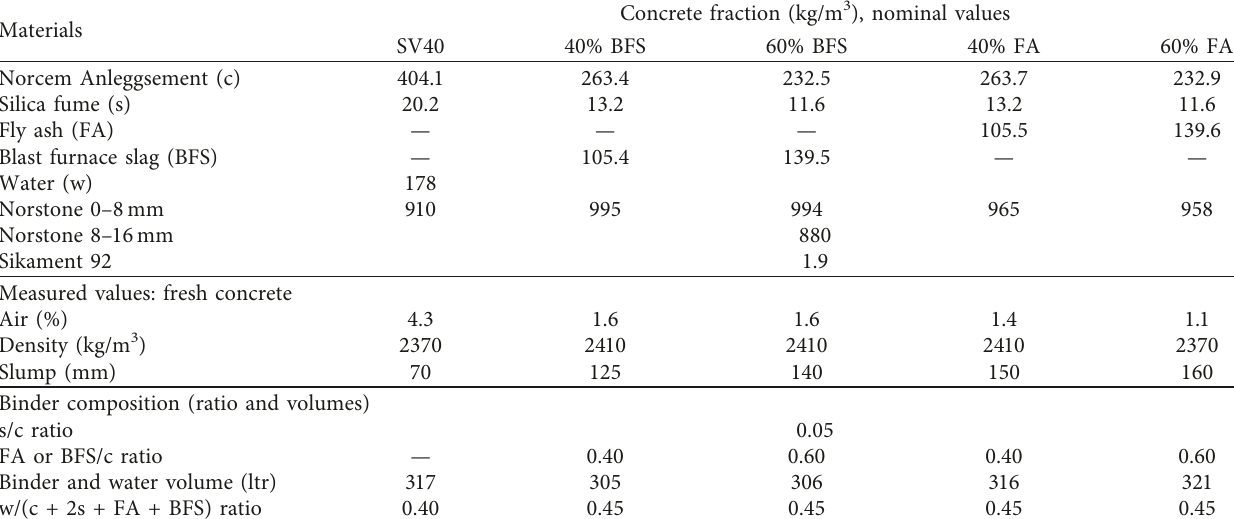
Figure 1: Bjørvika submerged Table 1: Concrete compositions and mechanical properties at 28 days.